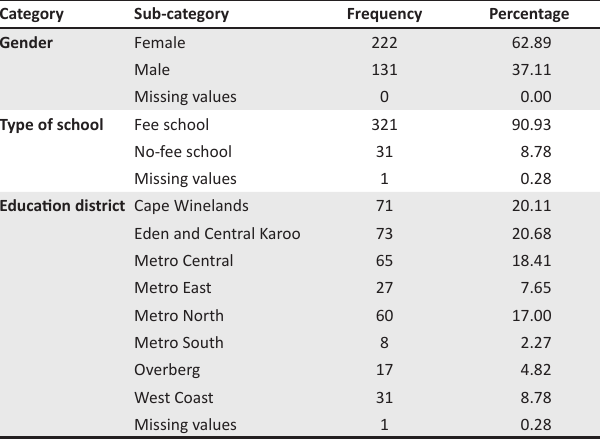
TABLE 1: Biographical characteristics of